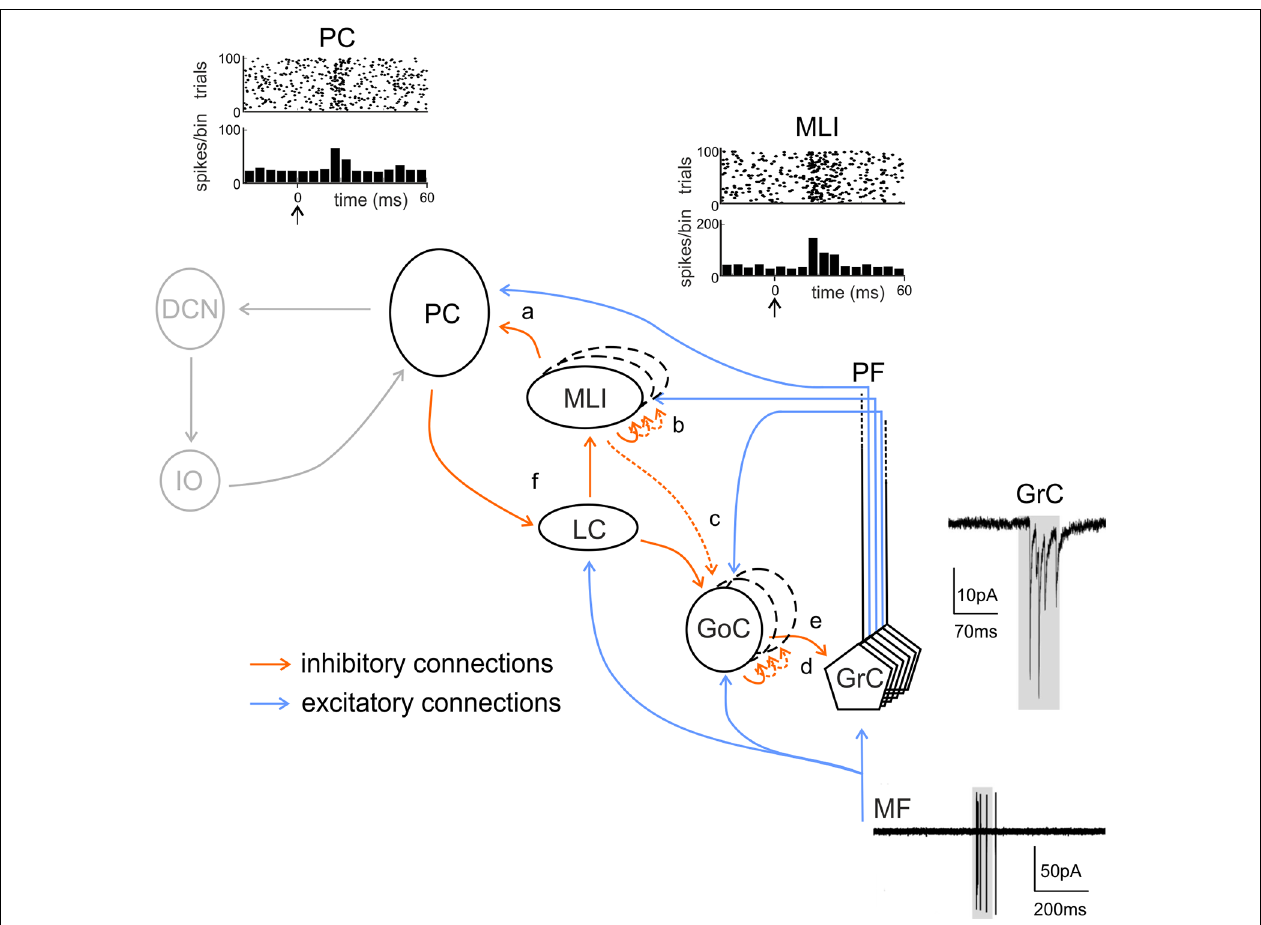
FIGURE 5 | Inhibitory chains in the cerebellar cortex. The scheme shows the main excitatory and inhibitory connections in the cerebellar cortical circuit. Note that feed-forward (FFI) and feed-back (FBI) inhibitory loops are integrated in a complex inhibitory chain. FFI: (a) A PC may be both directly excited and then inhibited with disynaptic delay via ML interneurons (MLIs) activated by the same set of active PFs. (b) MLIs receive feed-forward inhibition (FFI) from each other. (c) MLIs, activated by PFs, inhibit Golgi cells (GoCs) in the same manner as PCs. This issue is somewhat controversial (see main text, dashed line). (d) Granule cells (GrCs) receive excitatory inputs from MFs. MFs also excite GoCs which provide FFI to GrCs. FBI: (e) through the PFs, GrCs activate GoCs that, in turn, inhibited GrCs in a feedback loop. (f) PC collaterals are known to inhibit LCs, which in turn inhibit MLIs. Activation of LCs by excitatory MF or monoaminergic inputs would lead to enhanced PC activity through disinhibition. In gray, non-cortical circuits involving DCN and IO. Traces show the activity of MF, granule cells, ML interneurons and PCs during tactile sensory stimulation in rodents. Adapted from Rancz et al. (2007) and Ramakrishnan et al. (2016). Noteworthy, the complex regulatory mechanisms brought about by the inhibitory interneuron chain remain to be investigated during dynamic signal